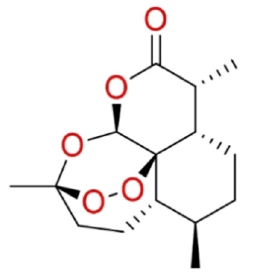
Figure 8. 2D structure of artemisinin.